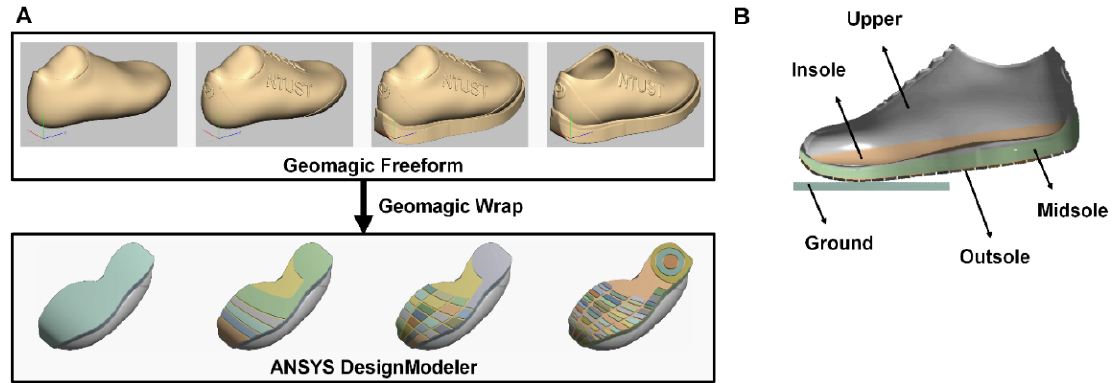
Figure 1. ( A ) The development process of the running shoe model; and ( B ), the anatomy of the 3D shoe and ground model.